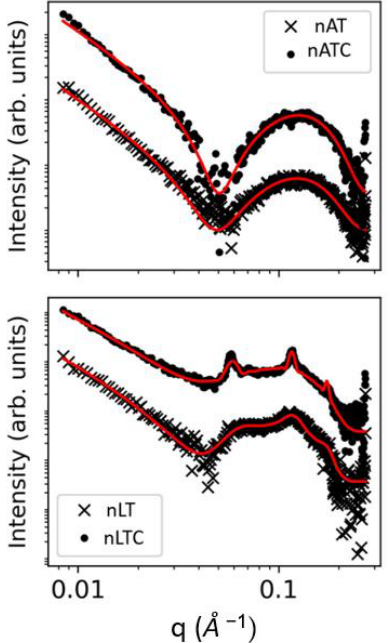
Figure 3. Raman spectra from ( a ) solid CUR; ( b ) CUR in Tris buffer; CUR in nanovesicles 200 µ g CUR/mL ( c ) nATC and ( e ) nLTC; void nanovesicles ( d ) nAT and ( f ) nLT; ( g ) CUR in Tween 80 micelles and ( h ) Tween 80 micelles.